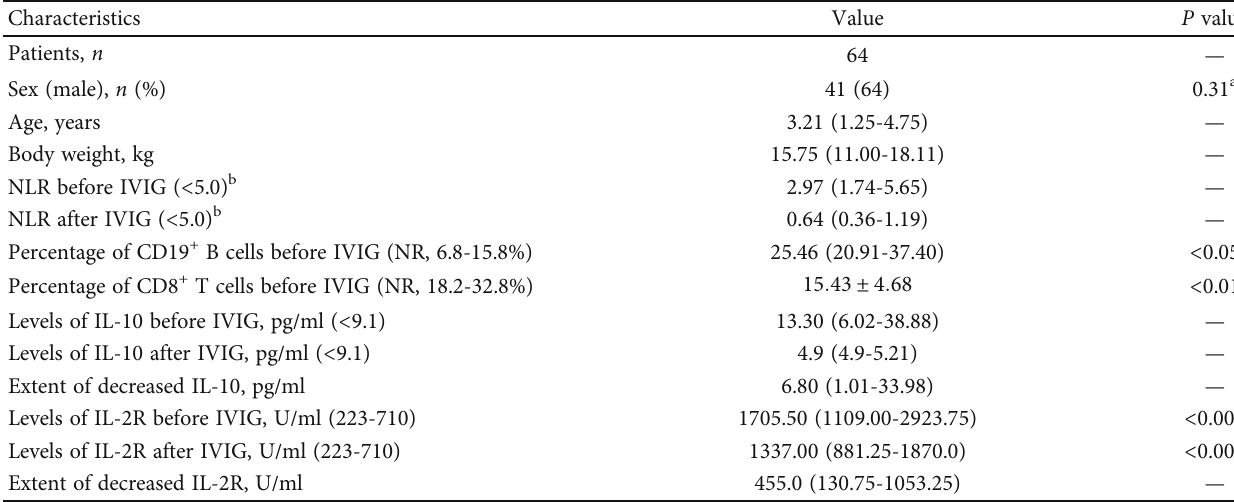
Table 1: Clinical and biochemical characteristics of the Kawasaki disease children.